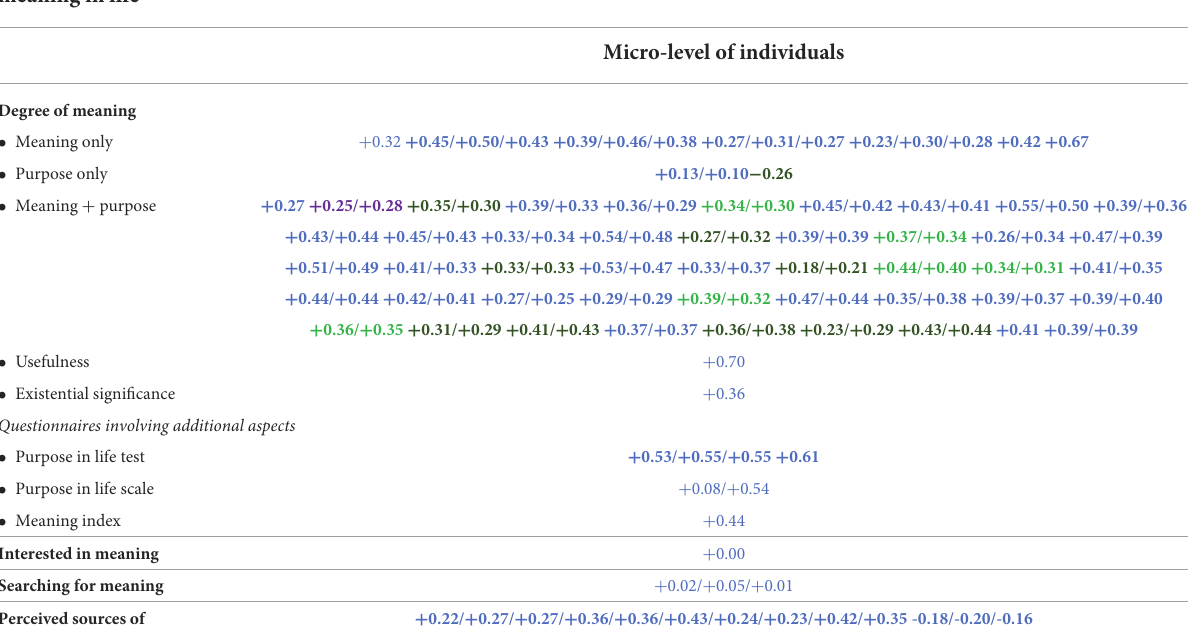
TABLE 4 117 findings on strengths of correlation between perceived meaning of life and satisfaction with life in Africa, Asia, Latin America, Middle East, and Western nations (Australia, Europe, and North America). Aspects of perceived Observed correlation with happiness in cross-sectional studies expressed in Pearson correlation meaning in life Micro-level of